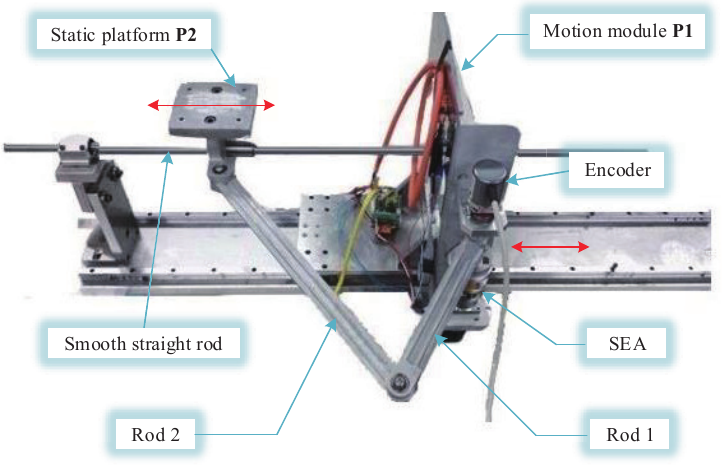
Figure 2. Self-built experimental stable